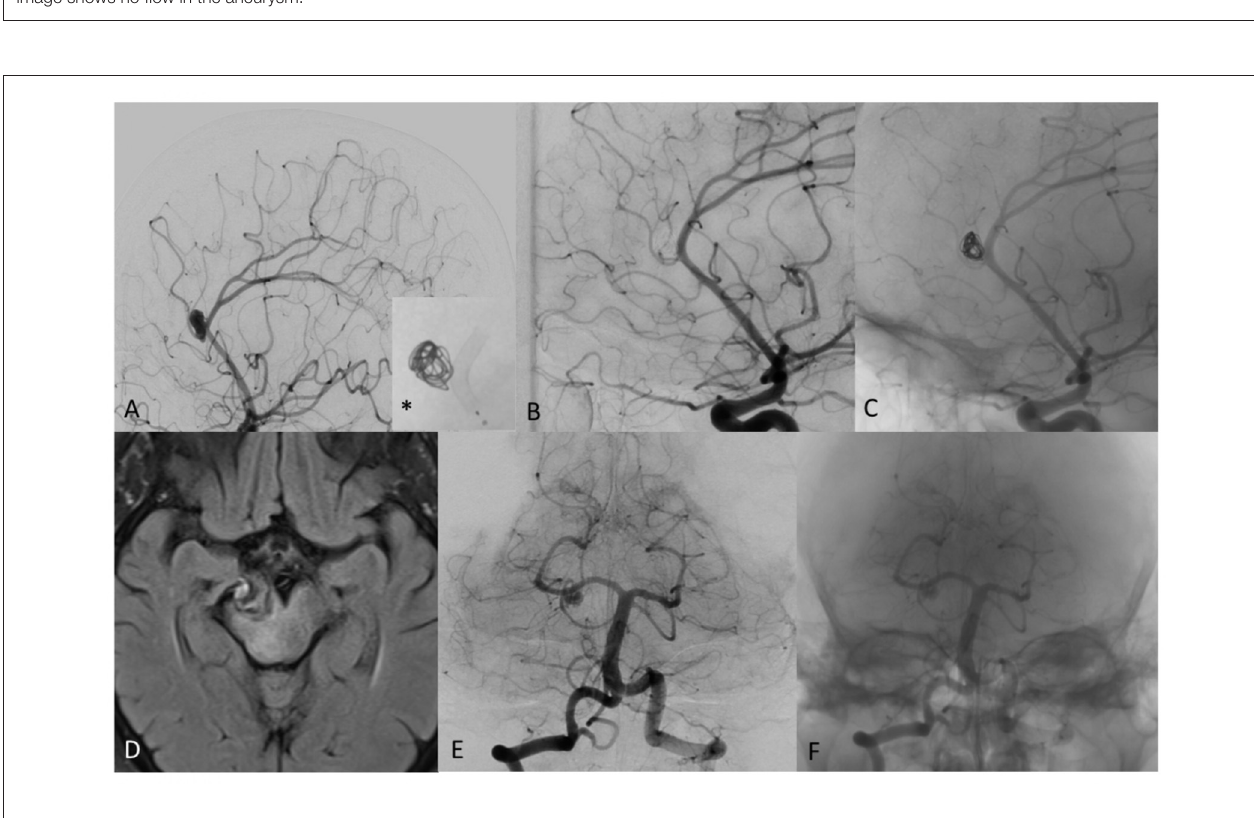
FIGURE 4 | (A) Digital subtraction angiography (DSA) of a patient with distal pericallosal-callosomarginal aneurysm treated with non-compact coiling and FD (*), to maintain the patency of callosomarginal artery arising from the neck aneurysm. (B) DSA shows complete occlusion of aneurysm sac at 6-month follow-up (stent diameter: 2.25mm, length: 15mm). (C) Un-subtracted image where it is possible to see the stent and the flow of contrast with the coils of the same patient at 6 months showing complete exclusion of the sac, no contrast filling through the coils and regular patency of treated arteries. (D) T2 weighted MRI image of mostly thrombosed giant PCA aneurysm. (E) DSA 2-month follow-up after FD treatment with remnant neck patency in patient with significant clinical worsening. (F) Un-subtracted image where it is possible to see the stent and the flow of contrast in the proximal part of the neck aneurysm.